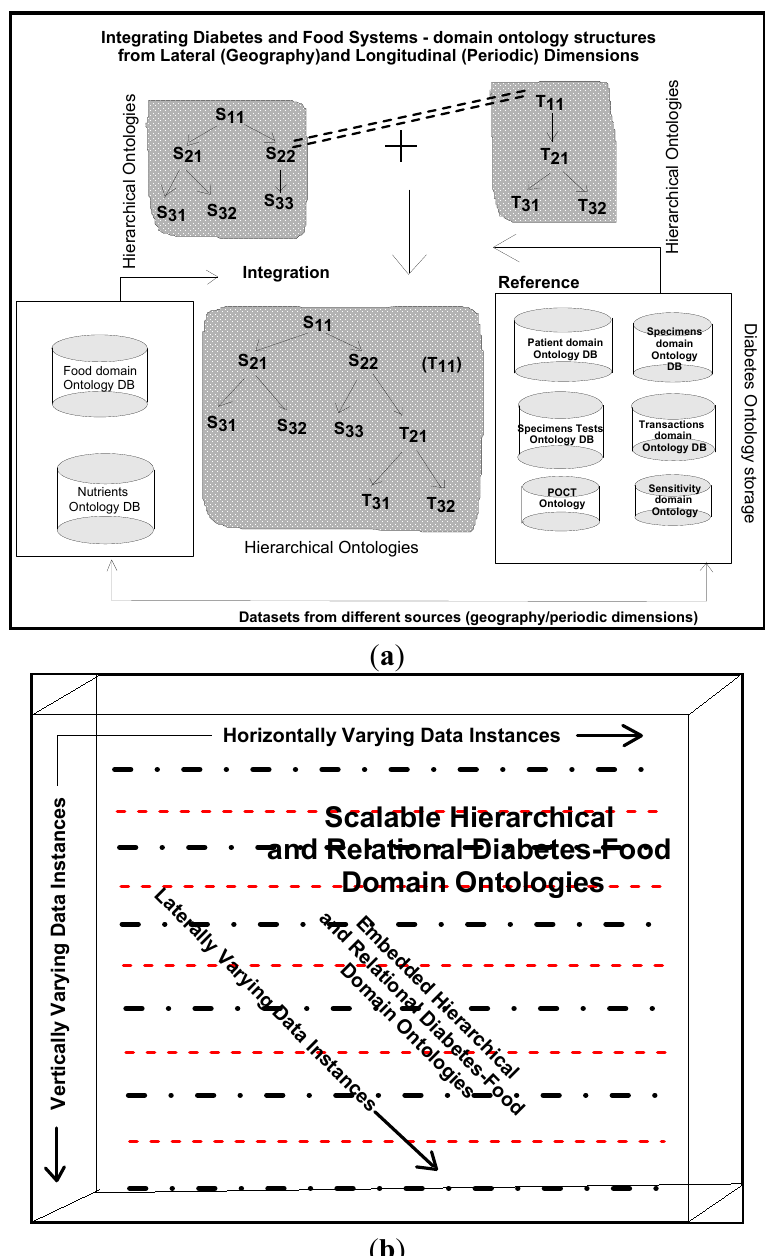
Figure 6. ( a ) A typical hierarchical data structuring model. ( b ) Horizontal, vertical and laterally varying data dimensions in 3D space region